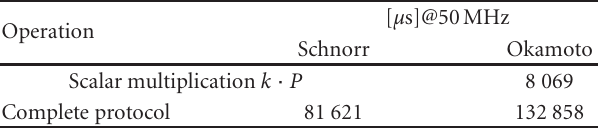
Table 2: Performance